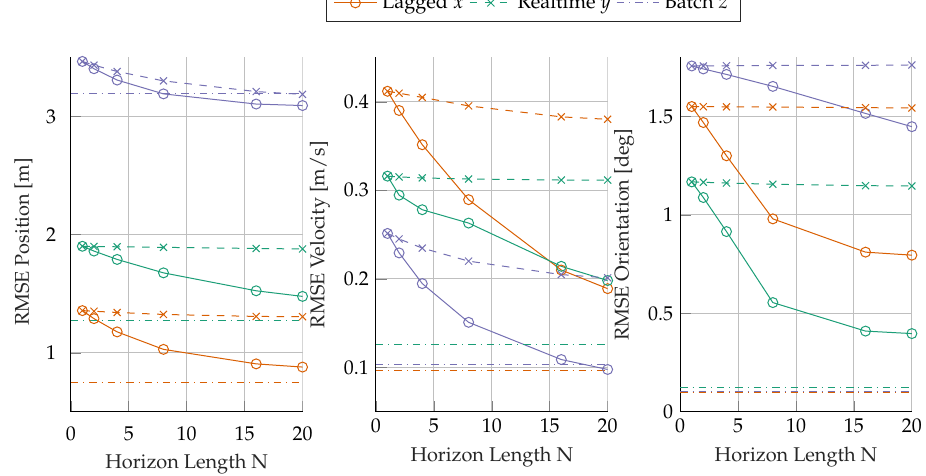
Figure 9. Evaluation of RMSE s for real-time ( ) and lagged ( ) MHE estimators over an increasing horizon length N compared to the batch estimation results (